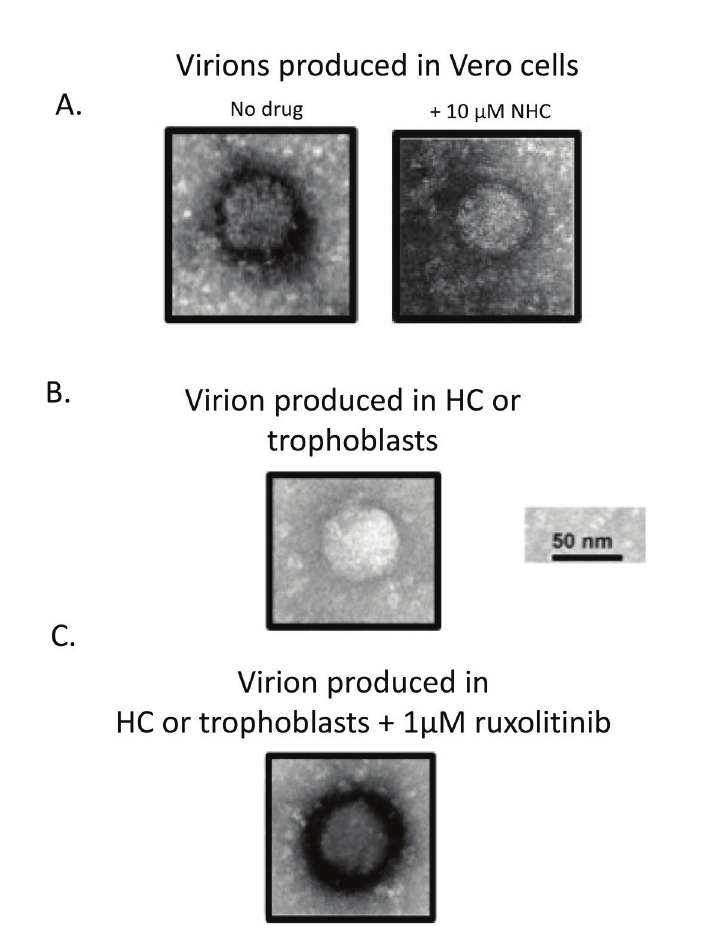
Figure 5. HC and trophoblasts produce “thin coat” ZIKV but “thick coat” viruses similar to Vero cells in the presence of ruxolitinib. Supernatants from Vero cells infected with PRVABC59 produce virions with “thick coats” (A; left panel) which were confirmed to be replication competent with supernatant transfer assays. Block of ZIKV replication in Vero cells with 10 µM NHC resulted in reduction of number of extracellular virions, however virions observed were “thick coat” (A; right panel). HC or trophoblasts infected with PRVABC59 produced “thin coat” viruses (representative images; B) whereas HC infected in the presence of 1 µM ruxolitinib produced “thick coat” viruses (representative images;